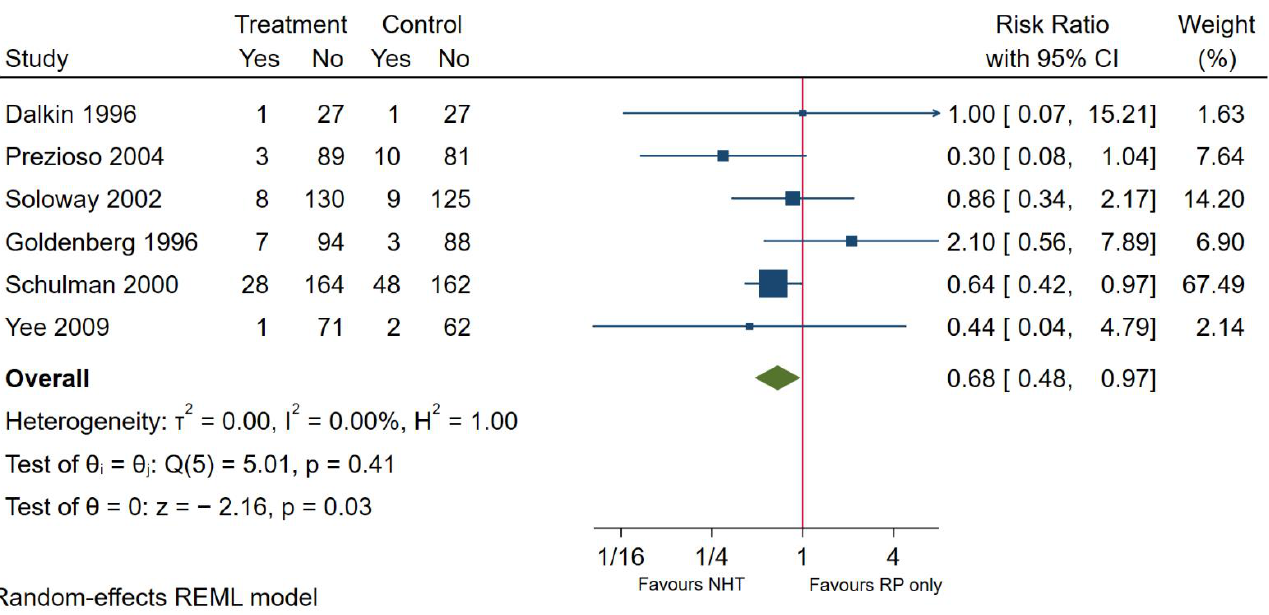
Figure 5. Lymph node involvement in patients undergoing 3 months NHT followed by RP or RP only.